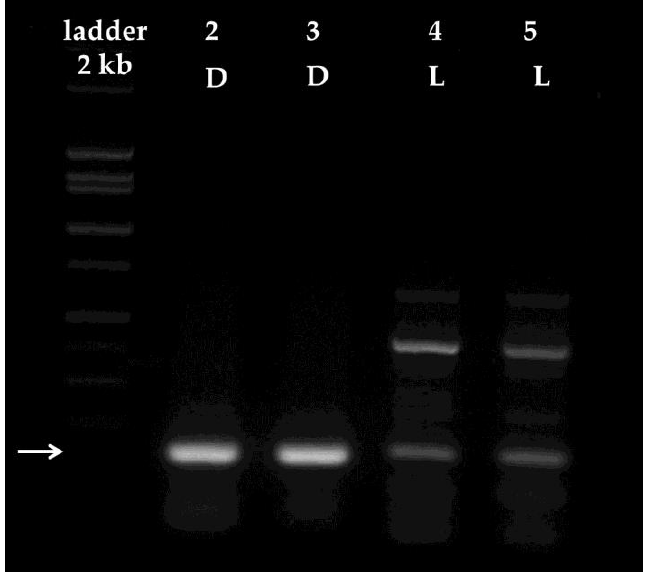
Figure 5. Amplification of a partial segment of the putative gene encoding for the isoprene synthase (IspS) enzyme. PCR products were separated on a 2% agarose gel stained with 0.5 µg/mL ethidium bromide. The arrow indicates the position of the 165 bp fragment of the putative IspS gene. Lanes 2 and 3 were loaded with representative reactions containing DNA templates isolated from dark-adapted leaves, using M1. Lanes 4 and 5 were loaded with representative reactions containing DNA templates isolated from light-adapted leaves, using M1. The white arrow annotates the position of the 165 bp fragments. D = dark-adapted; L = light-adapted.